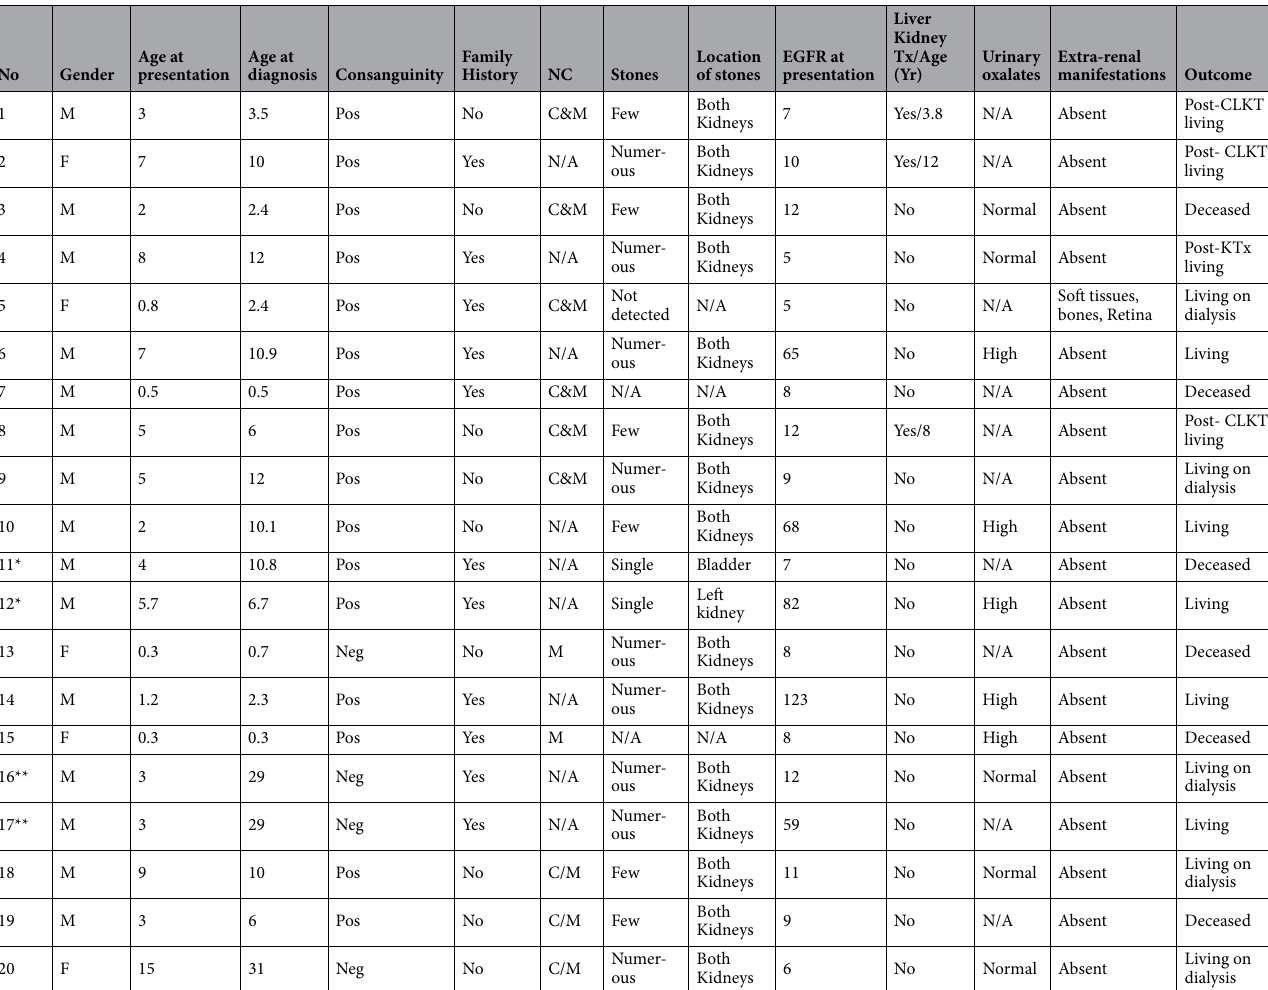
Table 1. Demographic and clinical features of Egyptian patients with PH ( N = 20). C Cortical, CLKT combined liver kidney transplantation, KTx kidney transplantation, M Medullary, N/A not available, NC nephrocalcinosis. eGFR was calculated using the Schwartz formula and the CKD-EPI formula for patients < 18 and > 18 years, respectively. High urinary oxalate is defined as > 0.50 mmol oxalate/1.73 m2/day in a 24 h urinary sample. * Siblings, ** Identical